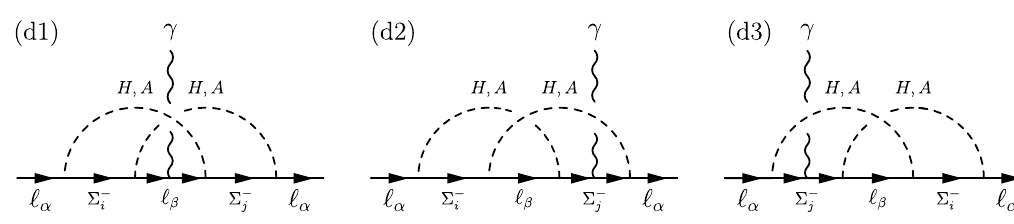
Figure 3 . Dirac type diagrams contributing to charged lepton